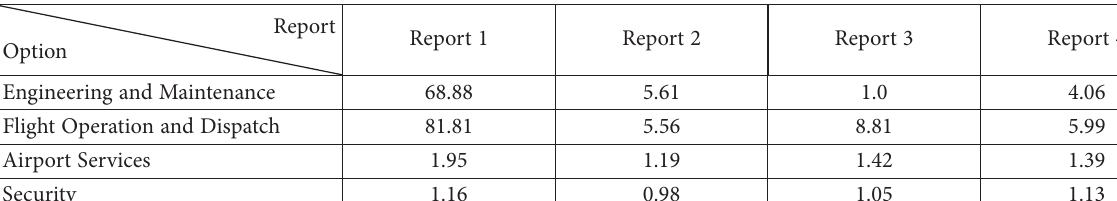
Table 5.Criteria comparison of received reports in Airport services department